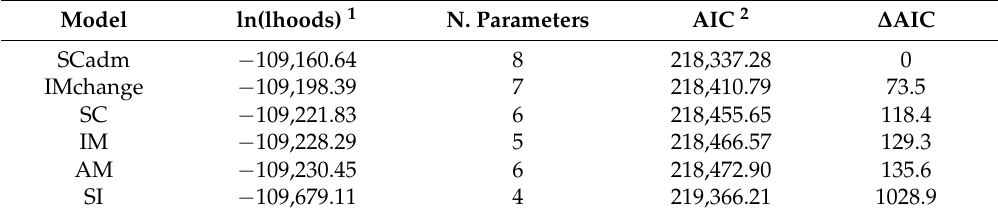
Table legend: 1 Admixture proportion from ferox into benthivorous brown trout; 1,2 Admixture proportion from benthivorous brown trout into ferox trout; 3 symmetric bi-directional migration rates; 4 Timing of secondary contact and 5 divergence time in generations. Effective population sizes (Ne) Table legend: 1 ln(likelihood), 2 Akaike information